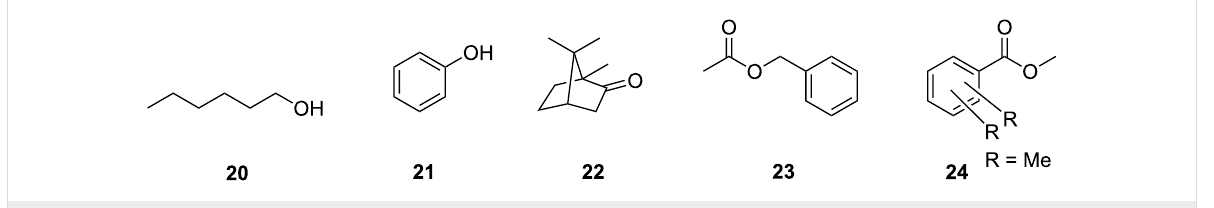
Figure 4: Volatiles released by M. tuberculosis grown in a 7H9 broth liquid medium.